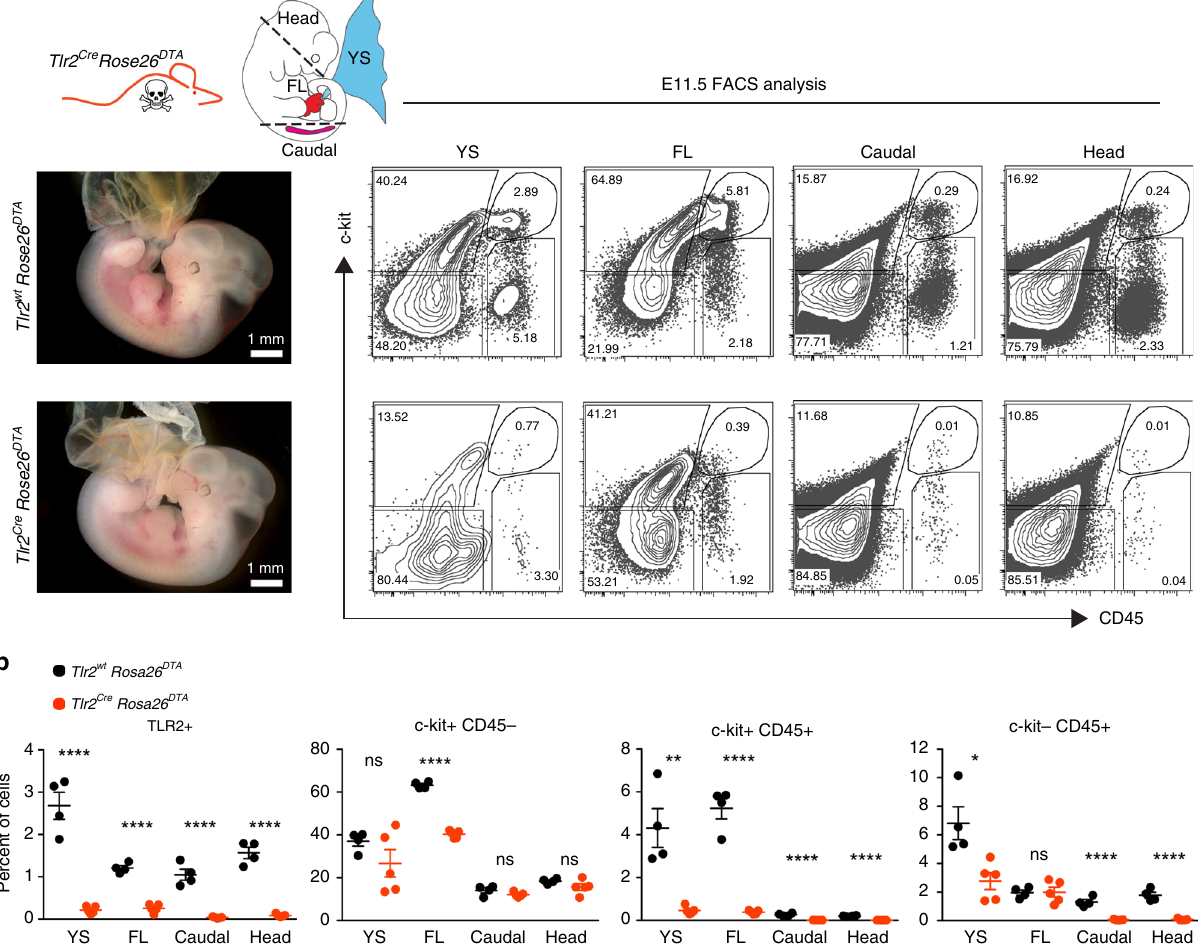
Fig. 5 Tlr2 -driven production of DTA ef fi ciently deletes hematopoietic cells in E11.5 embryos. a Representative images of E11.5 Tlr2 wt Rosa26 DTA and Tlr2 Cre Rosa26 DTA embryos ( n = 4 independent experiments with 3 – 8 embryos of each genotype per experiment). FCM analysis ( a ) and its quanti fi cation ( b ) of TLR2 + , c-kit + CD45 – , c-kit + CD45 + , and c-kit – CD45 + cell subsets in the YS, FL, caudal part, and head of dissected E11.5 Tlr2 wt Rosa26 DTA (upper panel) and Tlr2 Cre Rosa26 DTA (lower panel) embryos (mean ± SEM; n = 4 – 5; **** p ≤ 0.0001, * p < 0.05; paired, two-tailed t test). Scale bar = 1 mm. Source data are provided as a Source Data fi